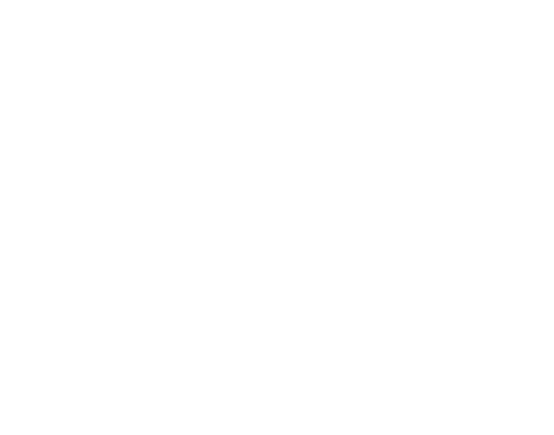
12 of 38 Figure 5. Treatment of peritoneal macrophages infected with intracellular amastigotes of T. cruzi